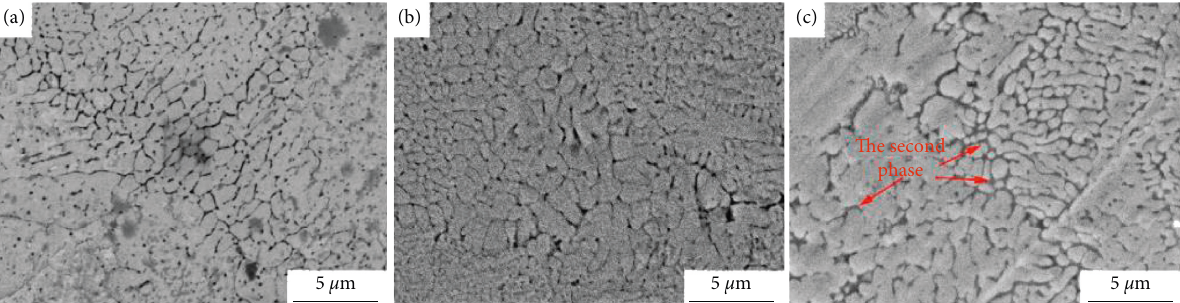
Figure 7: The microstructure of different compositions (a) Mo-4.5Si-2B, (b) Mo-4.5Si-3.5 B, and (c) Mo-5Si-5B.